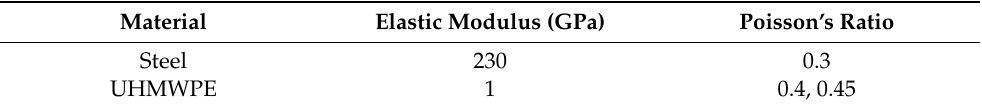
Table 2. Material